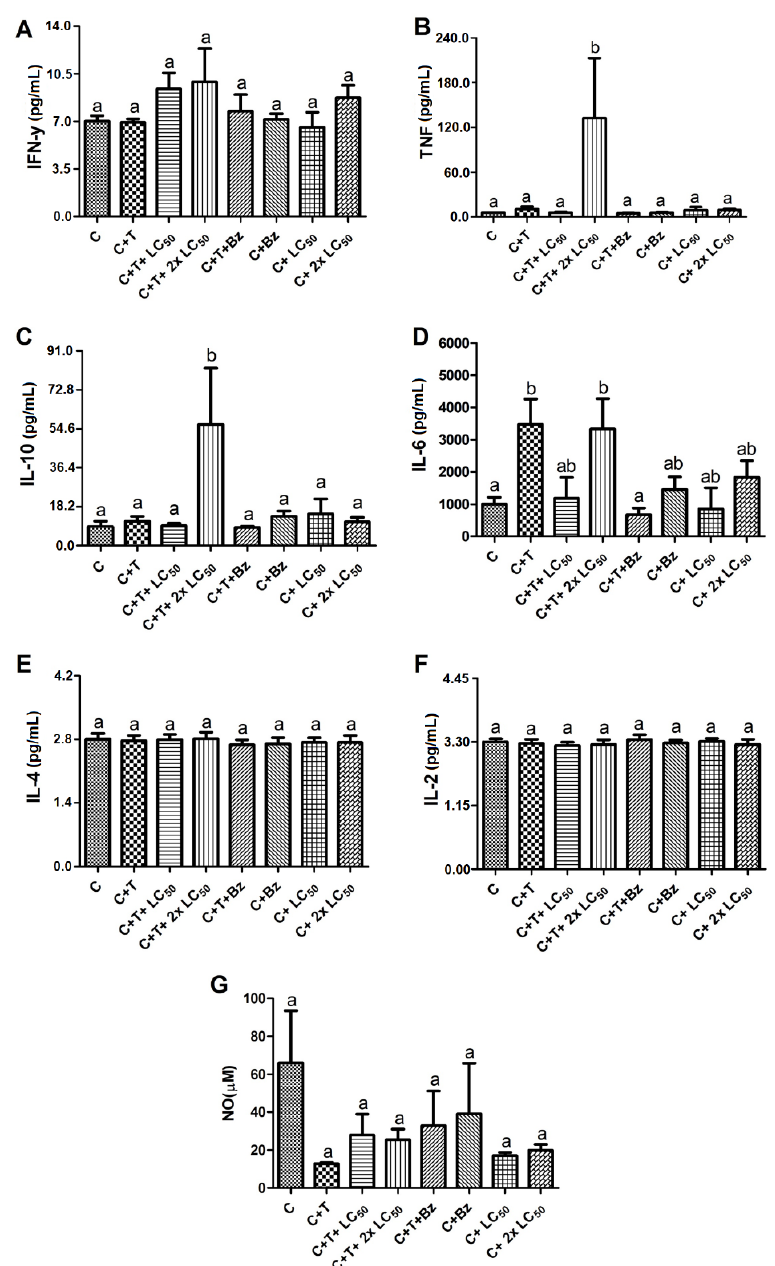
Figure 4. Effect of M. oleifera flower trypsin inhibitor (MoFTI) on the production of cytokines ( A – F ) and nitric oxide ( G ) by human peripheral blood mononuclear cells (PBMCs) infected or not with T. cruzi trypomastigotes after 48-h exposure. The treatments were: negative control (C = untreated and uninfected PBMCs); untreated PBMCs infected with trypomastigotes (C + T); infected PBMCs treated with MoFTI at 43.5 µg/mL (C + T + LC 50 ) and 87.0 µg/mL (C + T + 2 × LC 50 ); infected PBMCs treated with benznidazole (C + T + Bz); uninfected PBMCs treated with benznidazole (C + Bz); uninfected PBMCs treated with MoFTI at 43.5 µg/mL (C + LC 50 ) and 87.0 µg/mL (C+ 2 × LC 50 ). Different letters (a,b) indicate significant differences between treatments by analysis of variance (ANOVA) followed by the Tukey post-test ( p < 0.05).